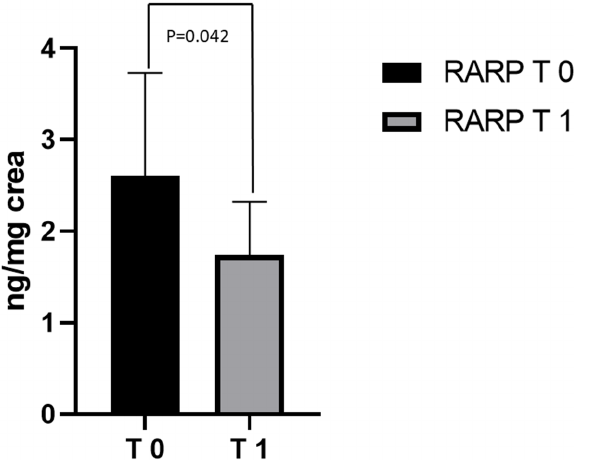
Figure 1. 8-OHdG levels in PCa patients at T0 and CTRL. Levels of 8-OHdG measured in urine from PCa patients (at T0) and CTRL subjects. Data are represented as means ± SD.